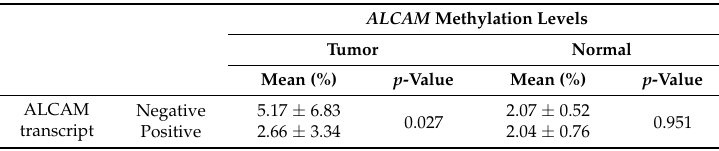
Table 1. Association of methylation levels of the activated leukocyte cell adhesion molecule ( ALCAM ) gene and its expression in tumor tissues and normal breast